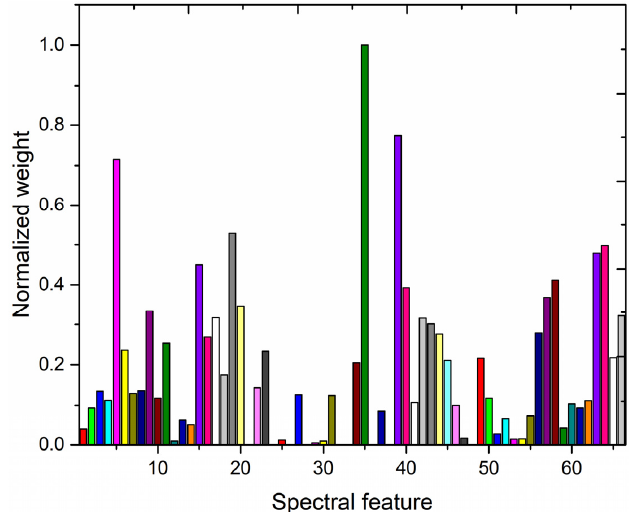
Figure 6. Normalized weight values of 66 variables obtained for the importance assessment of the LIBS spectral lines using the LASSO method.